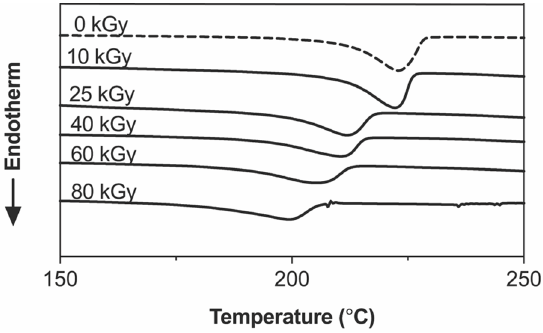
Figure 2. DSC analysis of the crosslinked PVA hydrogel sheets at varied irradiation doses.